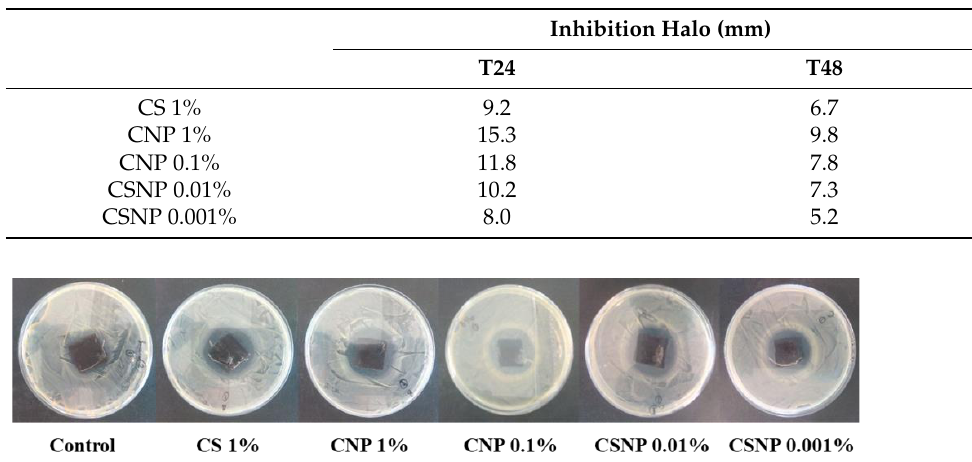
Table 2. Inhibition halo (mm) of leather samples obtained from dyeing industrial process D after treatment with CS 1%, CNP 1% or 0.1%, CSNP 0.01% or 0.001%, against S. aureus. The measurement of the halo presented is obtained by subtracting the control’s halo to the measure of the sample’s halo under study.